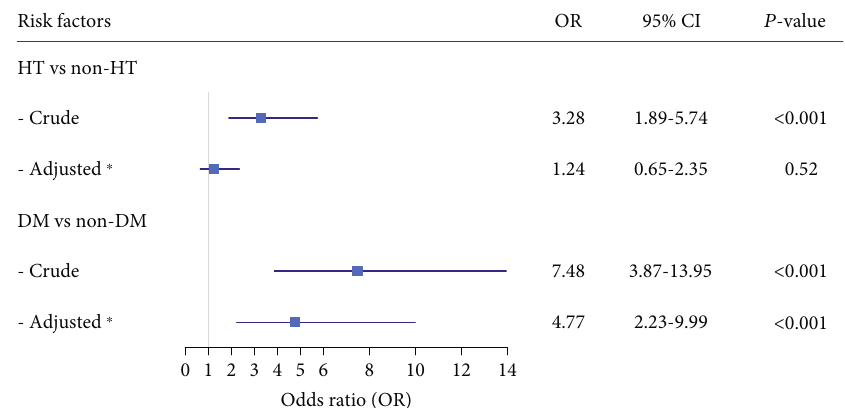
Figure 2: Association of new-onset HT and new-onset DM at baseline with all-cause mortality after 10-year follow-up. ∗ Model consisted of sex, age, BMI, eGFR, TG, HT at baseline, and DM at baseline. P value < 0.05 was considered statistically signi fi cant. DM: diabetes mellitus; HT: hypertension.